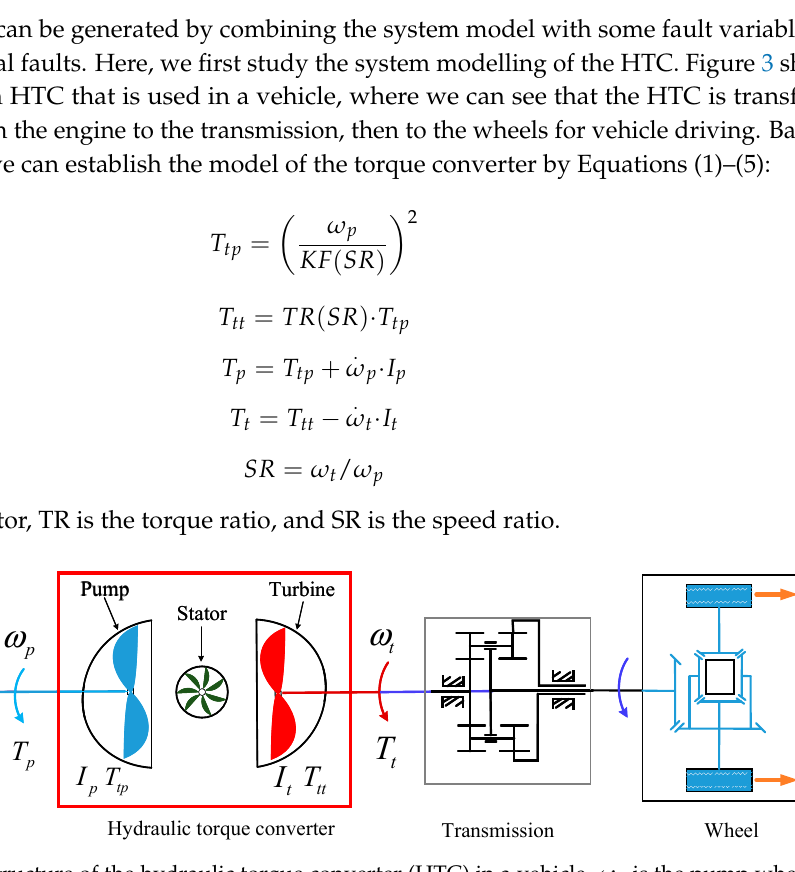
Table 2. Fault variables and their types, and the relationships between variables and critical faults in the HTC.